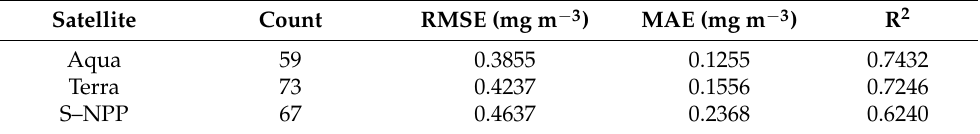
Table 1. Results were obtained by comparing Aqua, Terra and S–NPP data with in situ